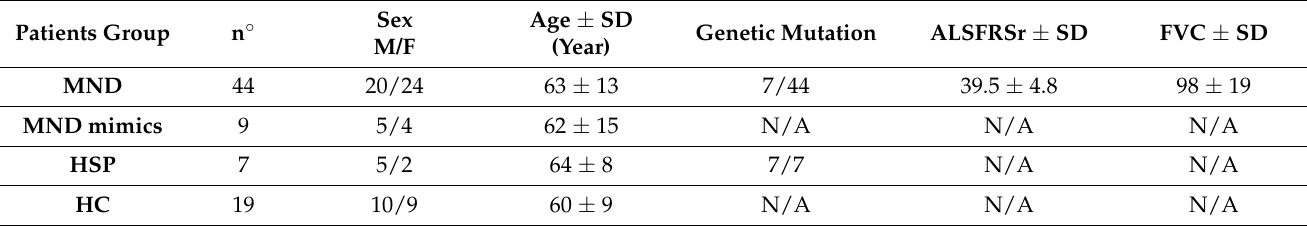
Table 1. Participant demographic and clinical information at blood